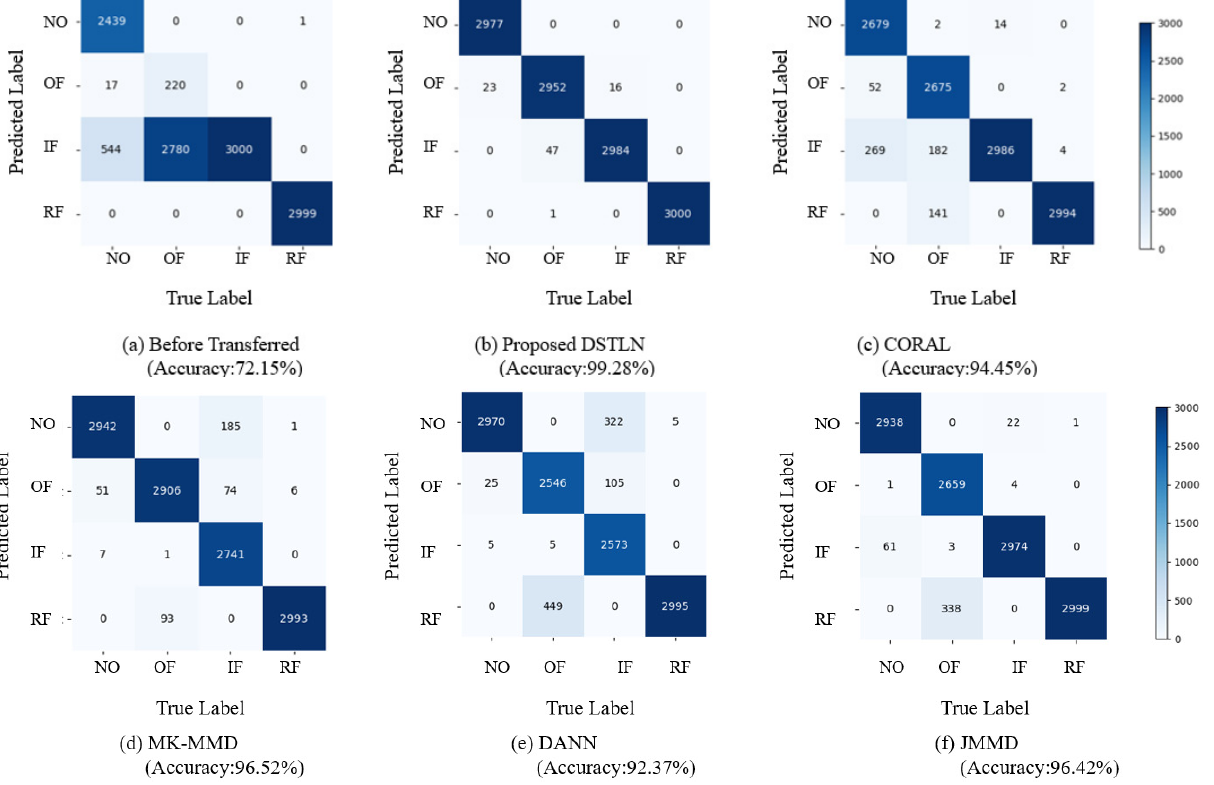
Figure 13. The diagnosis accuracy of target domain and confusion matrix results. (Results of before transferred, proposed DSTLN and other four contrast methods have been demonstrated, and the proposed DSTLN outperforms the others.)